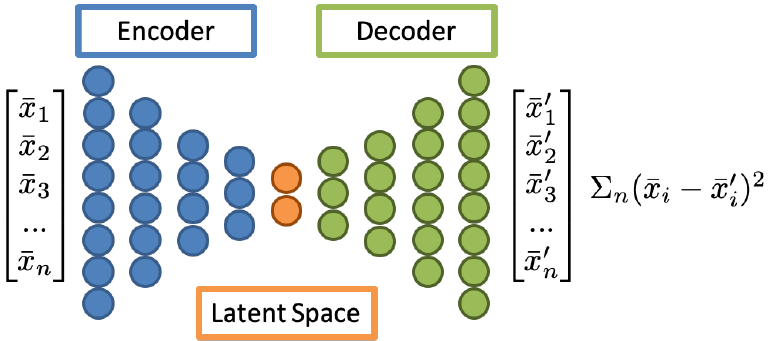
Figure 3. Schematic of autoencoder being used for anomaly detection. Once trained on x input data the autoencoder can be used on new data ¯ x . The root mean squared error of this reconstruction provides a metric for how similar the new data are to the training